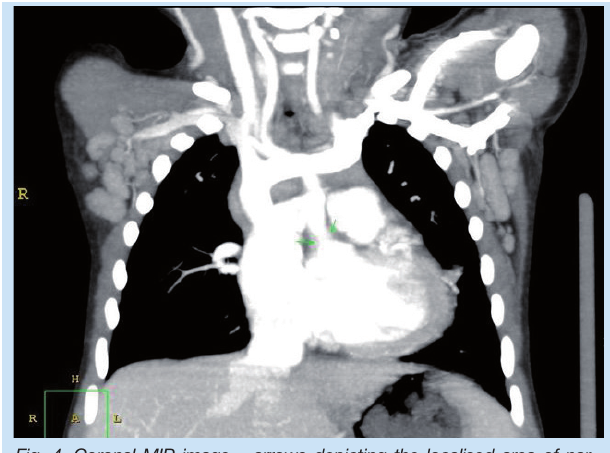
Fig. 4. Coronal MIP image – arrows depicting the localised area of nar- rowing visible above the aortic sinuses. The origins of the brachiocephalic vessels are